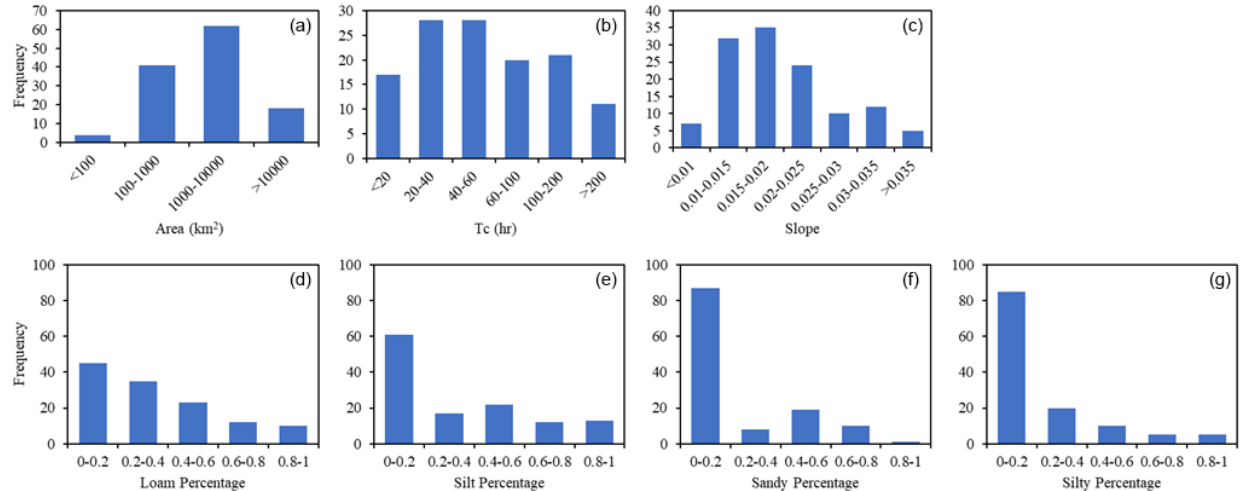
Figure 2. Histograms of the catchment area (a) , concentration time (b) , average slope (c) , and percentage of soil types including loam (d) , silt (e) , sandy clay loam (f) , and silty clay loam (g) for 125 USGS gauges in the State of Iowa. Table 3. Summary statistics for precipitation and streamflow among 125 catchments from water year 2012–2018. Missing rate as a limitation. Annual total Max. hourly Annual mean Missing rate of Missing rate of precipitation (mm) precipitation